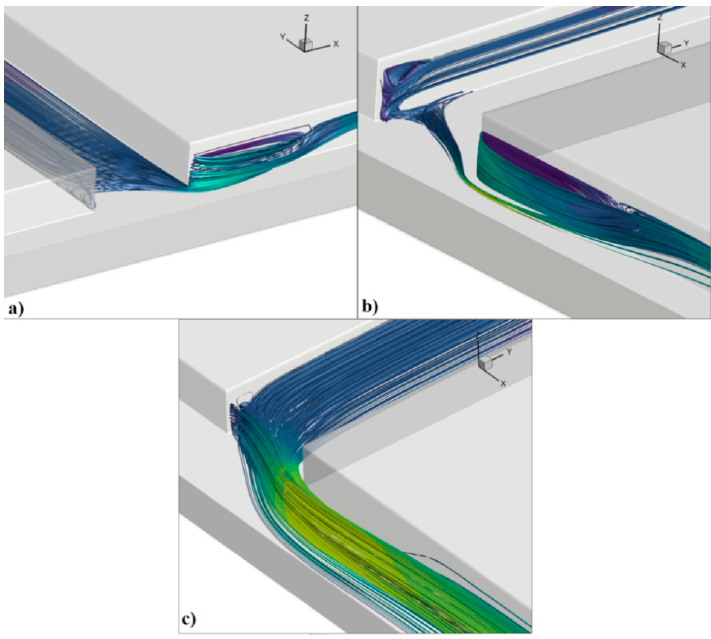
Figure 8. Three-dimensional streamlines at the confluence a) downstream view of recirculation, b) upstream view, and c) tributary flow.